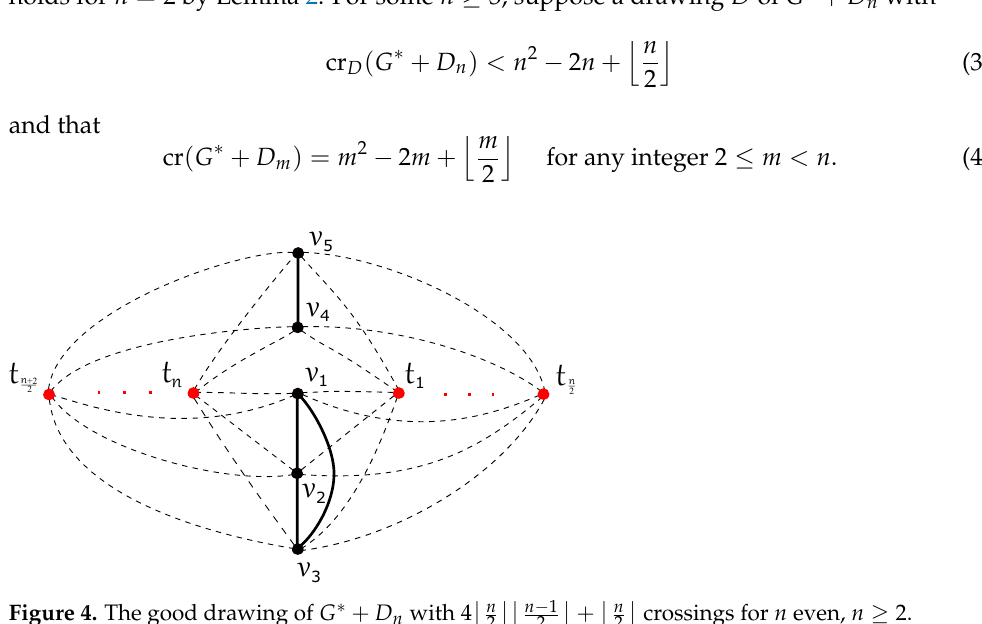
Figure 4. The good drawing of G ∗ + D n with 4